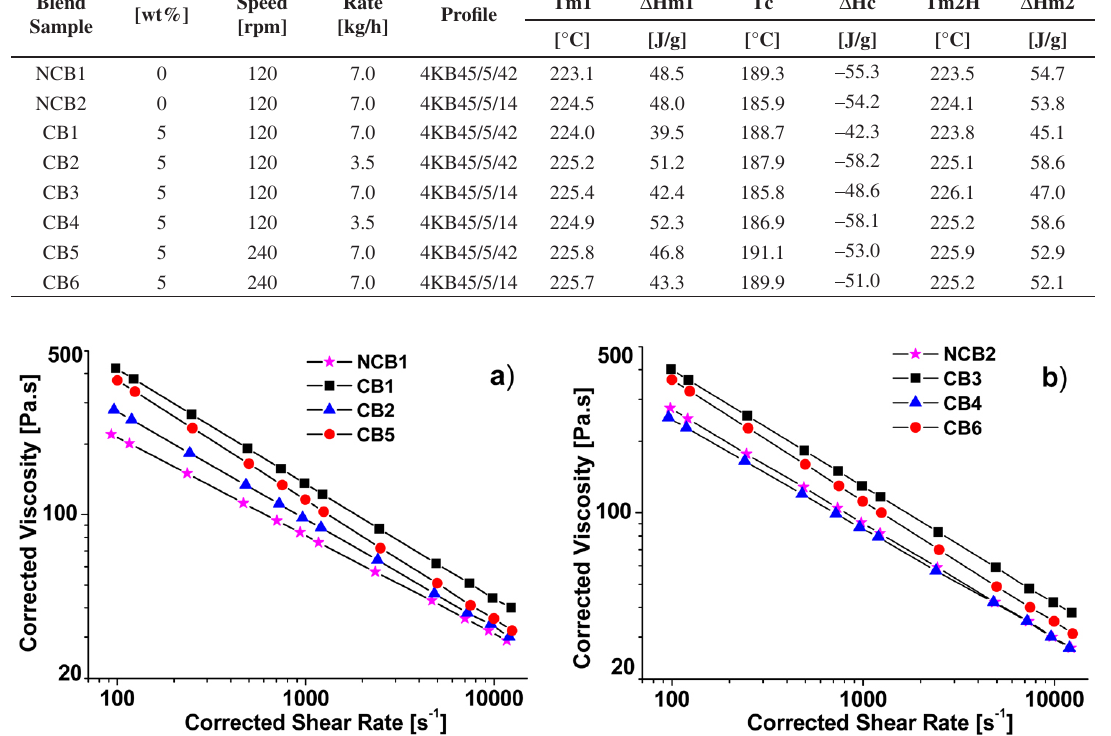
Table 2. Influence of the processing parameters on the melting behavior of the PBT/ABS blends prepared by extrusion. PBT/ABS Blend Sample